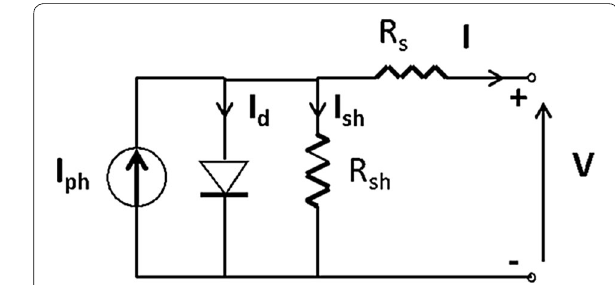
Fig. 1 Architecture of the PV system Fig. 2 PV panel equivalent